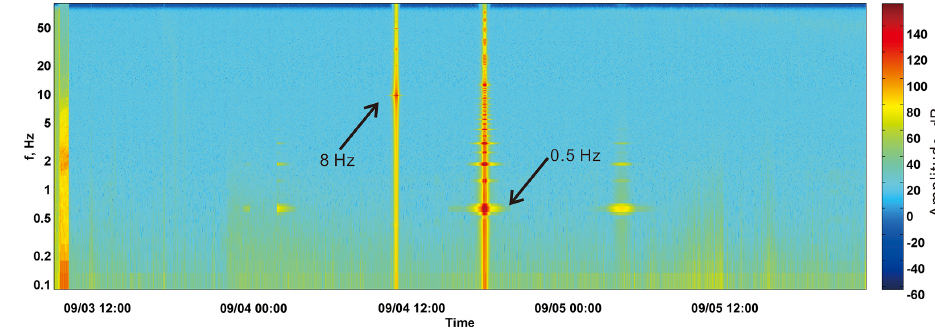
Figure 7. Short-time Fourier transform results for the CSEM signal from the horizontal electrical field components.